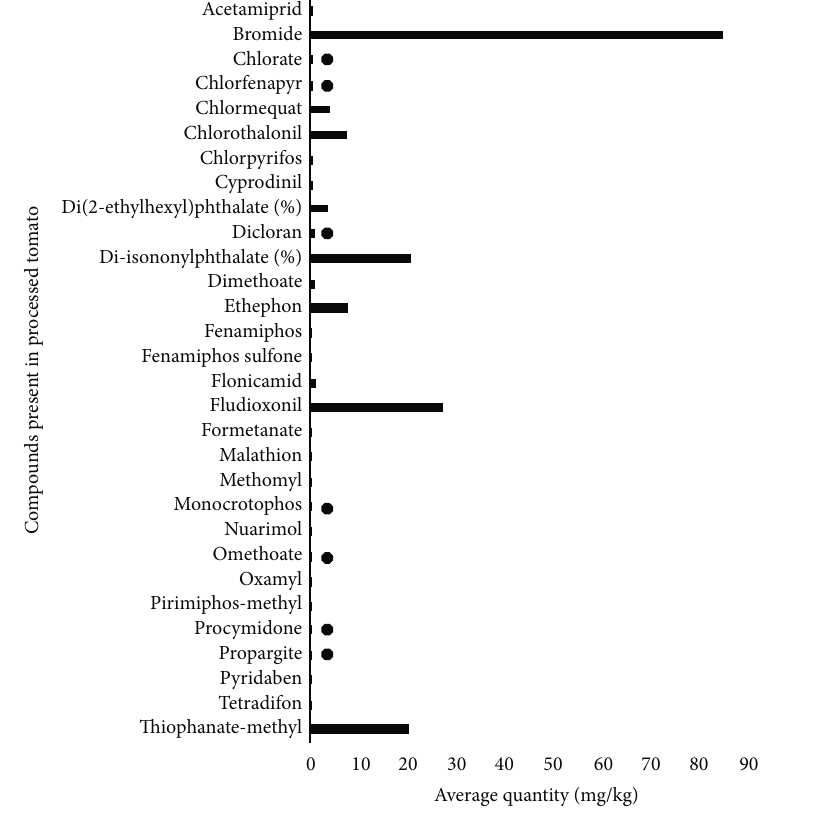
Figure 7: Pesticide residue levels reported by RASFF of the European Union in